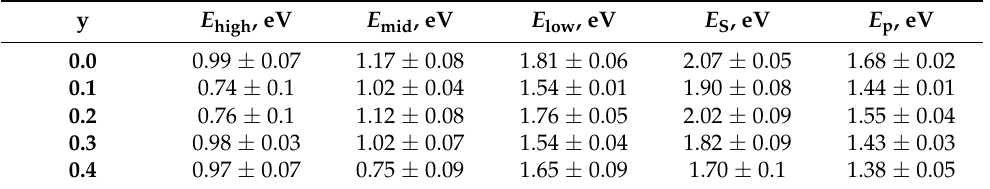
Table 5. Activation energies of the processes that contribute to the polarization resistance of